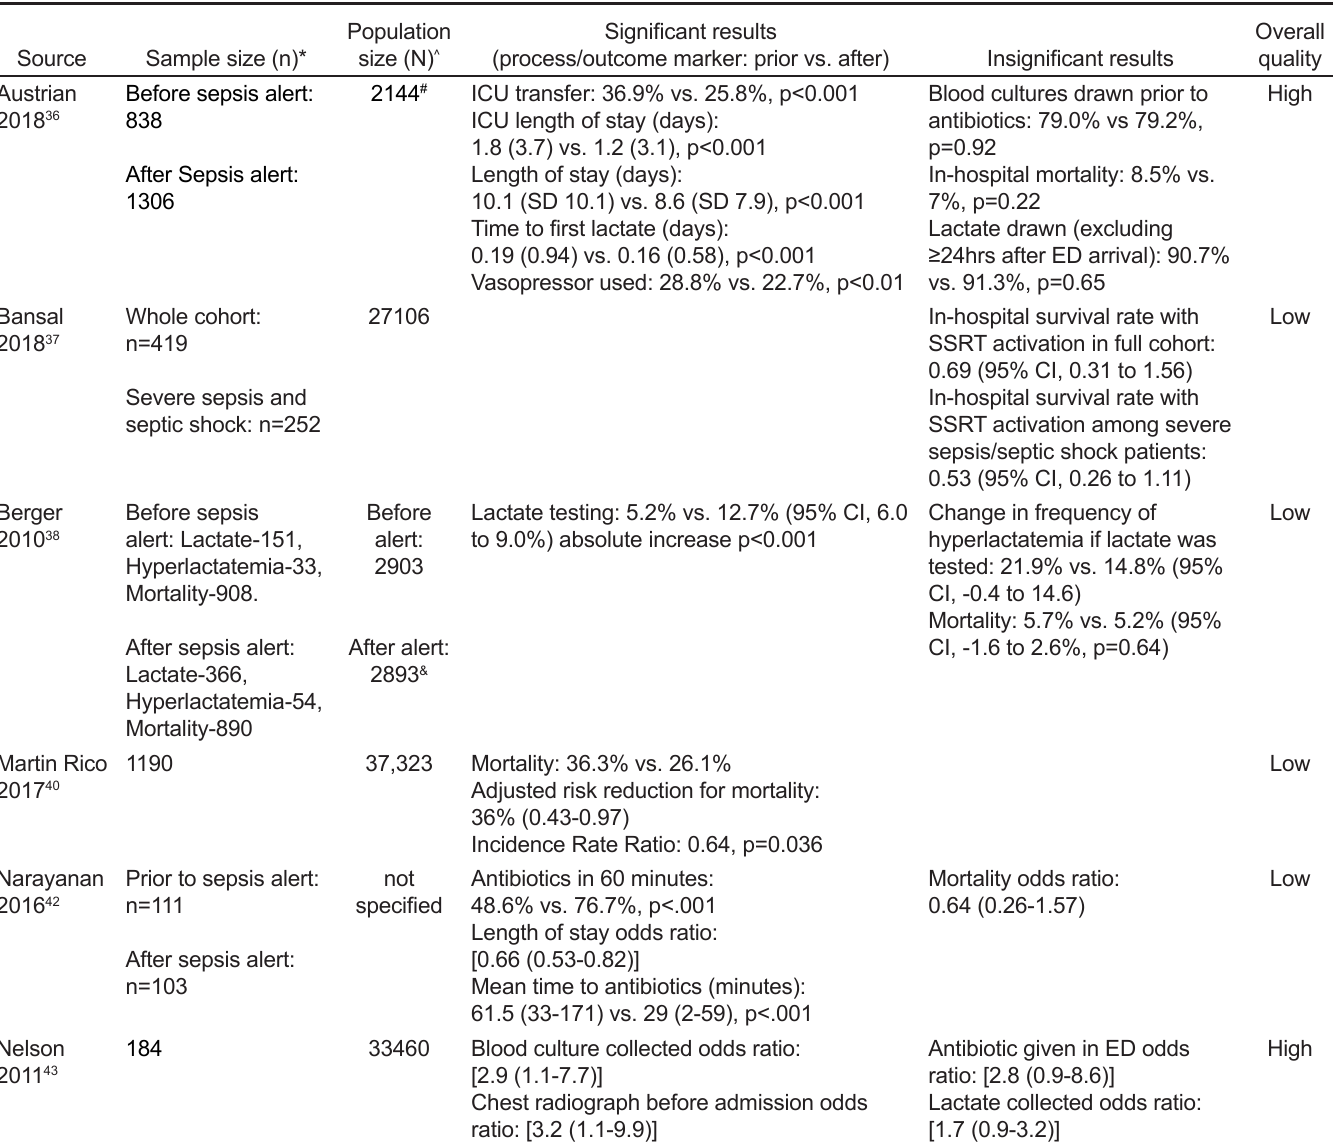
Table 3. Quality Sample size (n)*